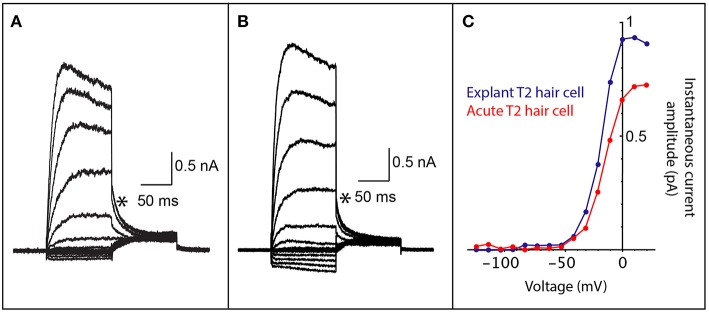
Comparison of whole cell patch clamp recordings from both acutely dissected and explant cultured vestibular hair cells. (A) Voltage-activated currents from the crista of a mouse type II vestibular hair cell, prepared as a vestibular triad explant preparation that was cultured for 2 days. (B) Voltage-activated currents from the crista of a mouse type II vestibular hair cell from an acute vestibular triad preparation (2 h post dissection). (C) An IV plot of instantaneous tail current amplitudes (measured at asterisks in A,B) from hair cells in cultured explant preparation (blue trace) and the acute vestibular triad preparation (red trace). The voltage-activated instantaneous tail currents from the explant preparation are comparable to those obtained from an acute preparation and are consistent with recordings from type II vestibular hair cells.